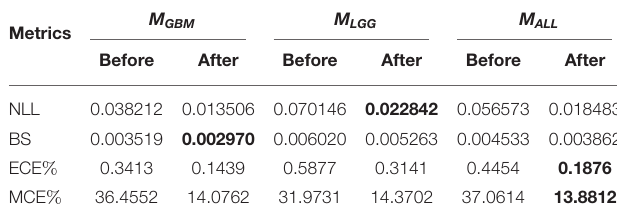
TABLE 1 | Split of patients in each of the three datasets. Dataset